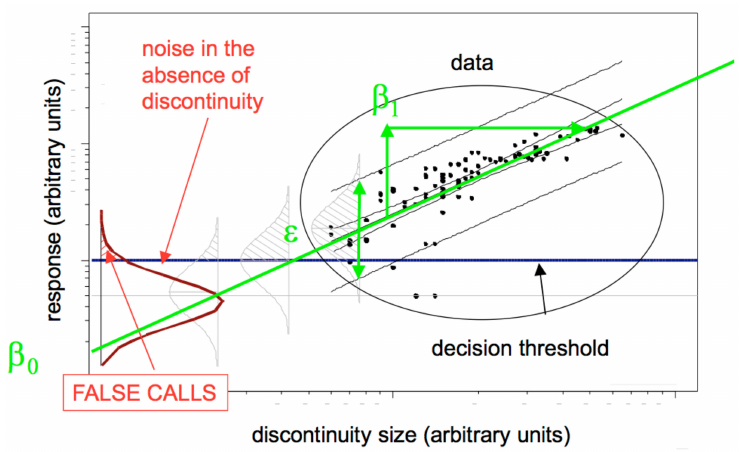
Figure 8. Damage index versus damage size (reproduced with permission from [70]) .